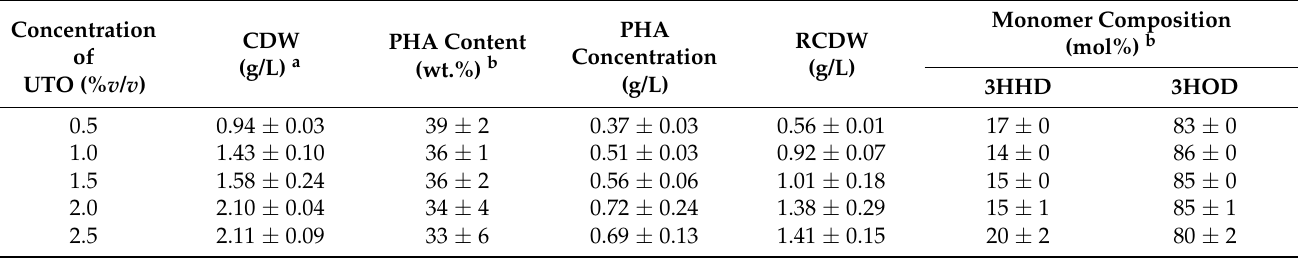
Table 2. Effect of concentration of the carbon source on growth and PHA biosynthesis by Acinetobacter sp. strain